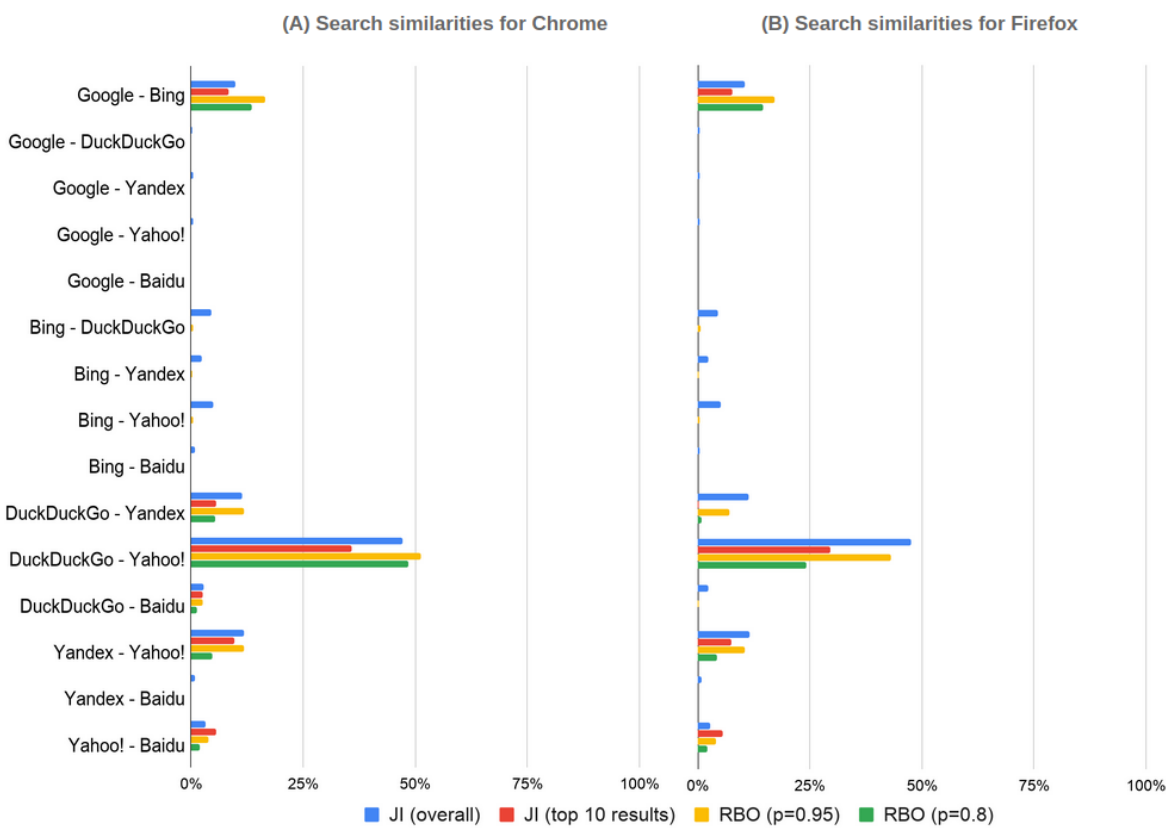
Figure 1. Average similarities (%) in search results for pairs of agents using different search engines. JI represents the Jaccard index and RBO stands for the Ranked Biased Overlap. The x-axis shows the average percentage for each of the similarity metrics, and the y-axis shows the pairs of search engines that are